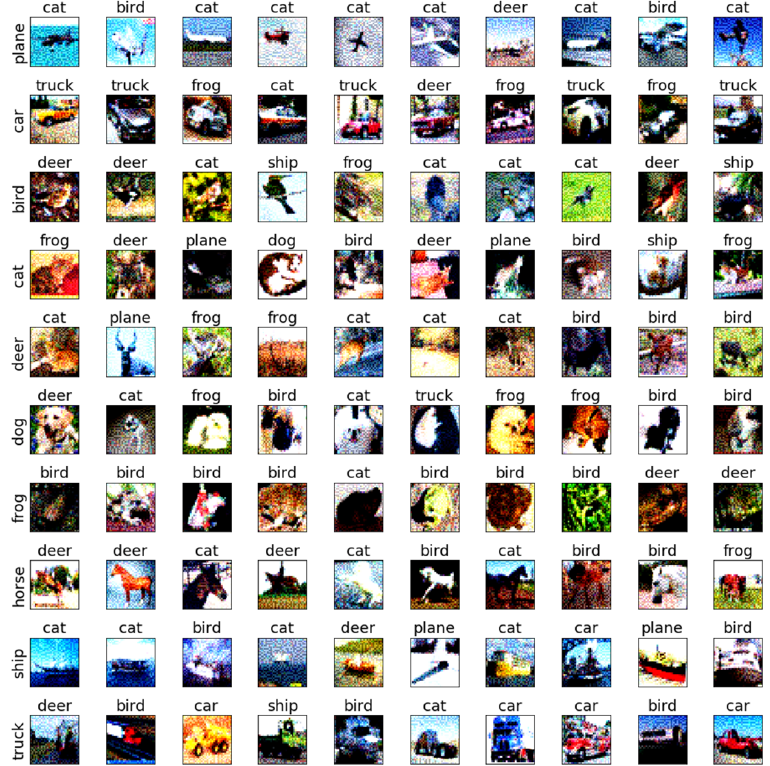
Figure 16. The adversarial examples of PGD for Cifar10 and ResNet18.